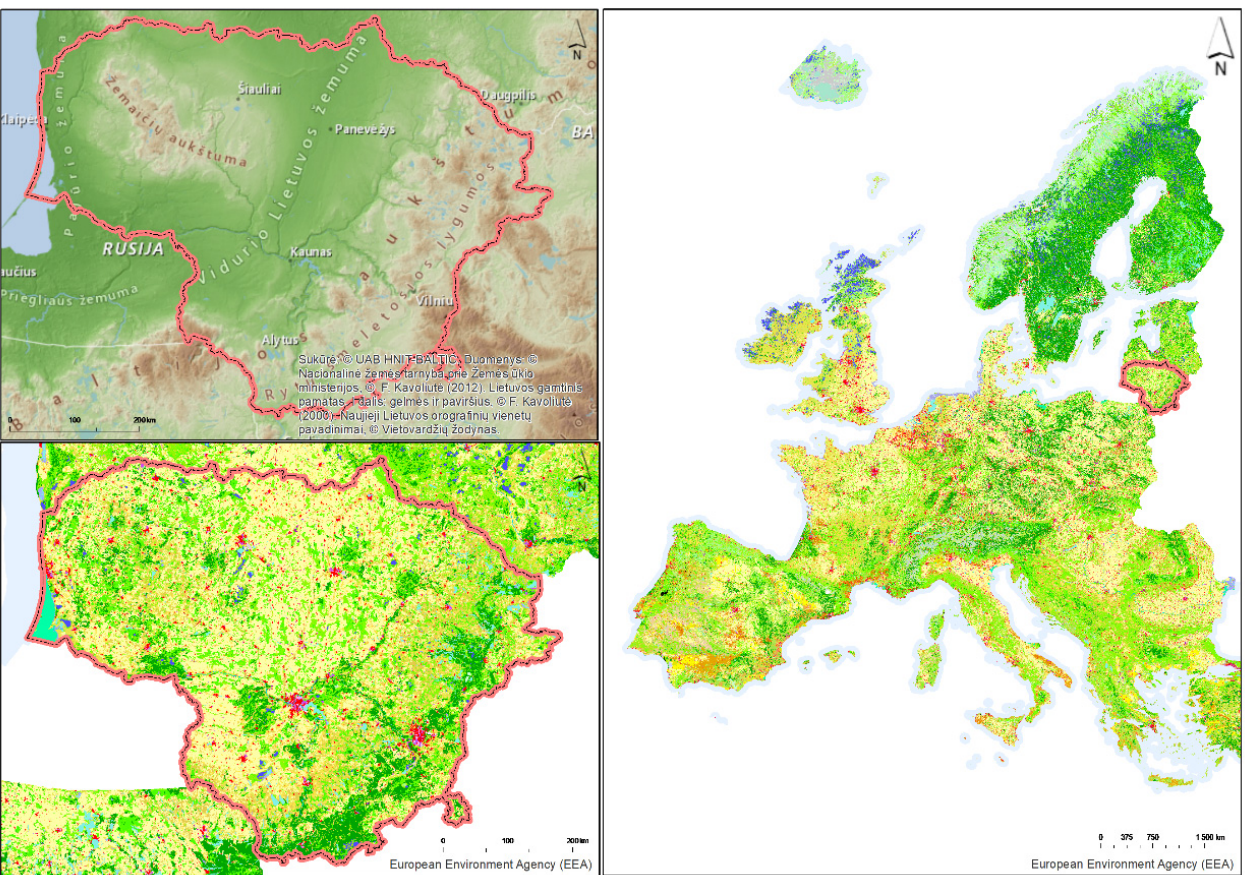
Figure 2. Study area. Physical map of Lithuania showing elevation ( top left ) and distribution by land use ( left ) and land use in Europe according EEA CORINE Land Cover 2018 data ( right ).